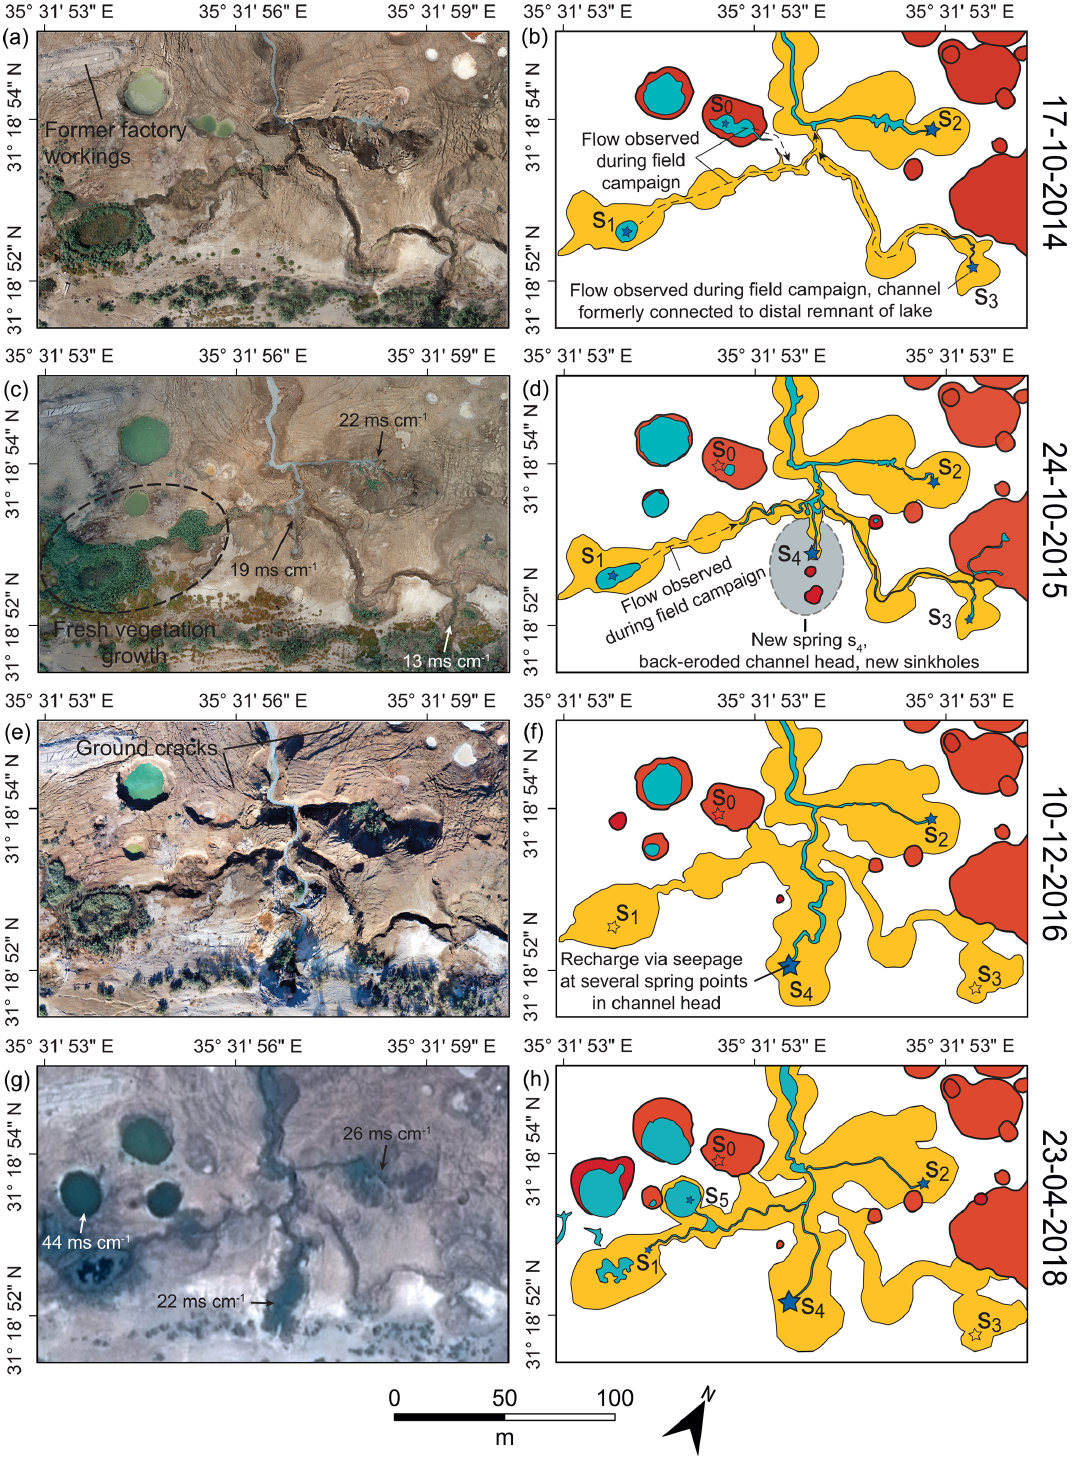
Figure 7. Evolution of the canyon–spring–sinkhole system close to the former mud factory at the head of CM5. (a, c, e) show aerial (balloon and drone, 2014–2016) or satellite imagery (2018). (b, d, f) show maps of the channel (yellow), surface water (blue) and sinkholes (dark orange). Filled stars indicate active springs; empty stars indicate previously active springs. The size of the filled stars indicates the approximate relative contribution of that spring to the flow downstream of the T junction between waters of the easterly and westerly springs.